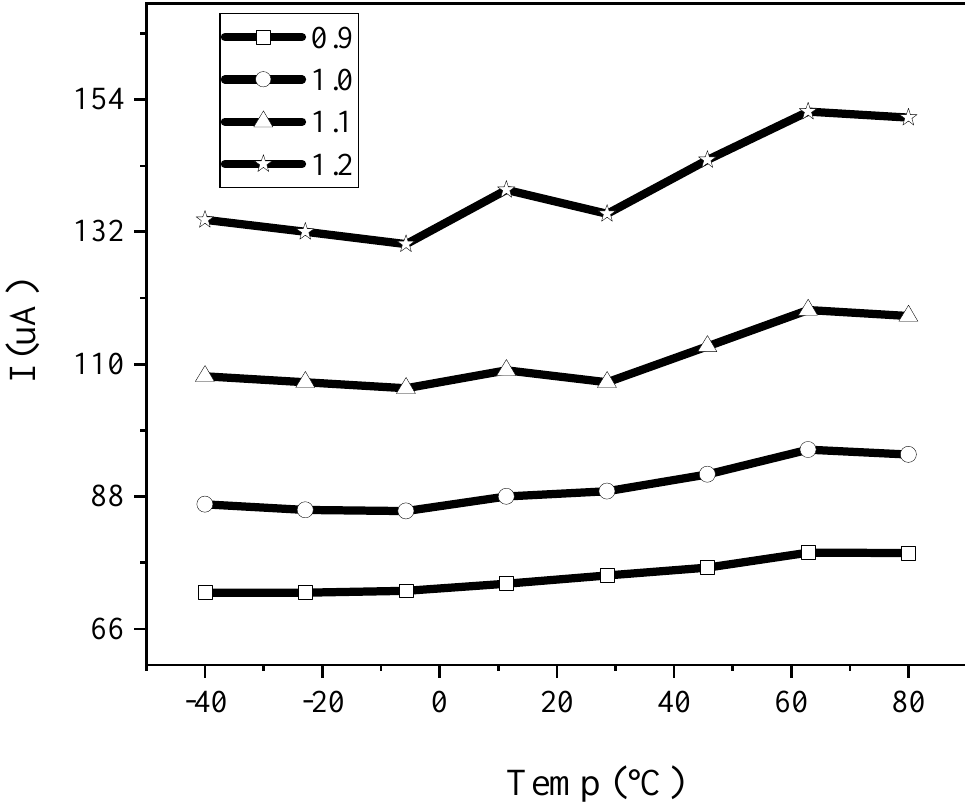
Figure 12. Simulation of proposed proposed two-row multiplier to temperature and voltage